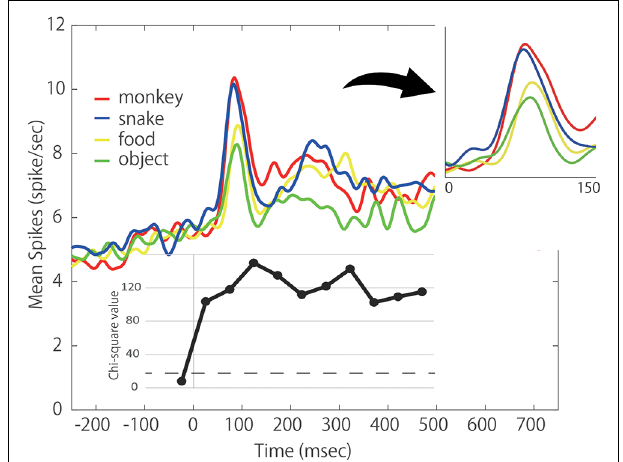
FIGURE 5 | Population response of the 46 photo-responsive ACC neurons. Each colored line indicates the respective spike density function (SDF) to each stimulus category; red: Monkey Face , blue: Snake , yellow: Food , green: Object . Lower inset: chi-squared values of Friedman test comparing the firing rates between four categories during a 50 ms period just before the stimulus onset and 10 50 ms periods of the Response period. Right inset: expanded view of population activity during 150-ms after stimulus onset. All data points show a significant difference at p < 0.0001 level. The dashed line indicates the chi-squared value of p < 0.05